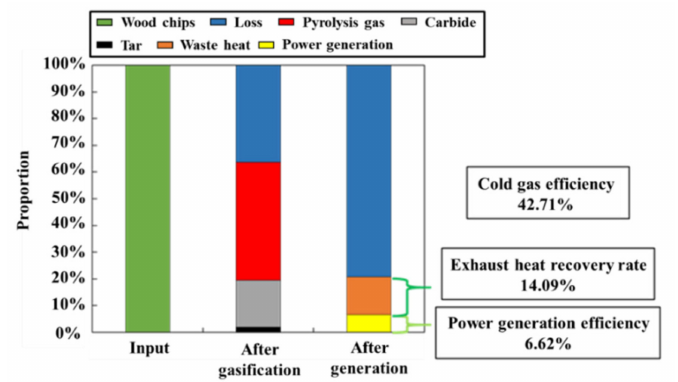
Figure 11. Heat balance of gasification process (from 30 May 2017 to 4 June 2017). Reprint with permission; JSME, 2020